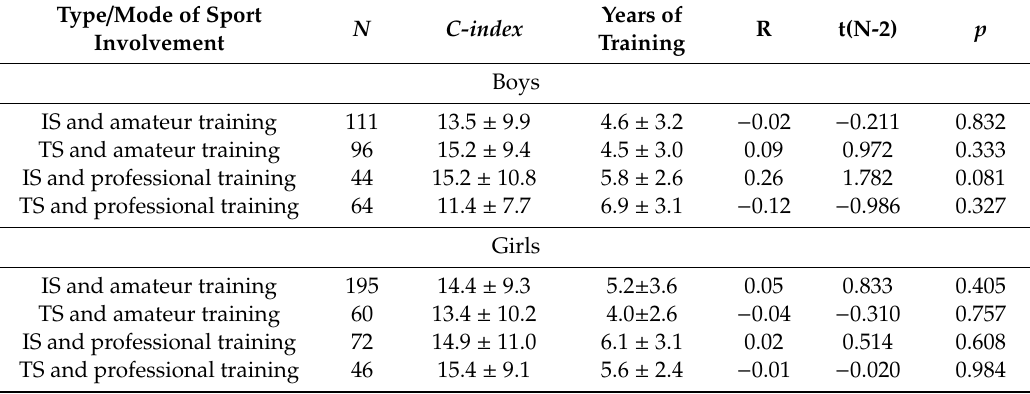
Figure 1. Two way interaction between various modes of involvement in sports and the level of moral competences in boys and girls. Table 2. Spearman correlation between years of training (M ± SD) and moral C-index in adolescents. Type / Mode of